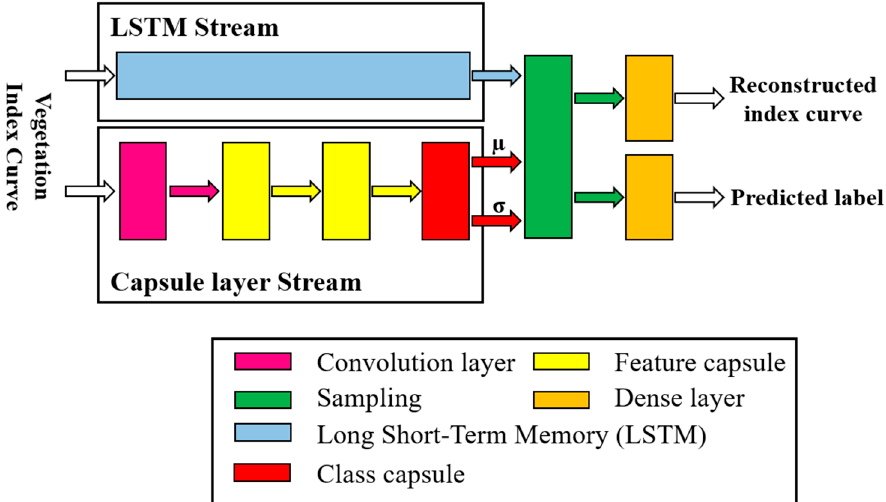
Figure 2. Proposed variational capsule network (VCapsNet) architecture without pooling (µ and σ denote mean and standard deviation, respectively).